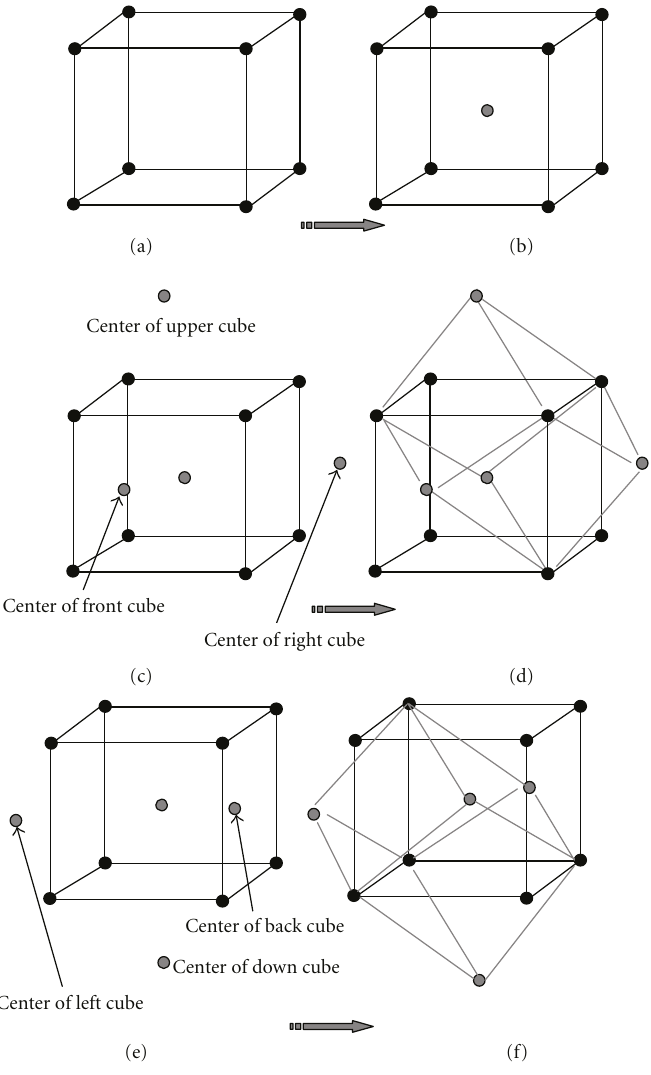
Figure 7: Body-centered cubic